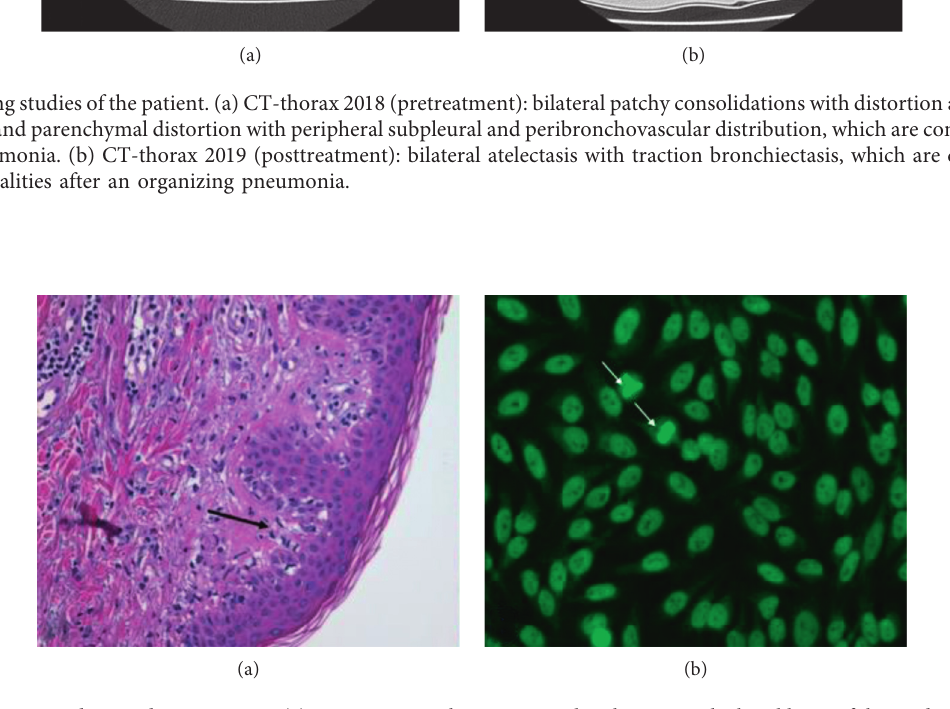
Figure 2: Skin biopsy and ANA determination. (a) H&E staining showing vacuolar changes in the basal layer of the epidermis (arrow) and perivascular lymphocytic infiltration of the dermis. (b) The IIF HEp-2 pattern showing a positive ANA with combined nuclear dense (AC-2) and fine speckled (AC-4) pattern (http://www.ANApatterns.org), the latter being compatible with anti-SAE1 reactivity. Arrows indicate fine speckled nucleoplasm in mitotic cells outside chromatin mass.